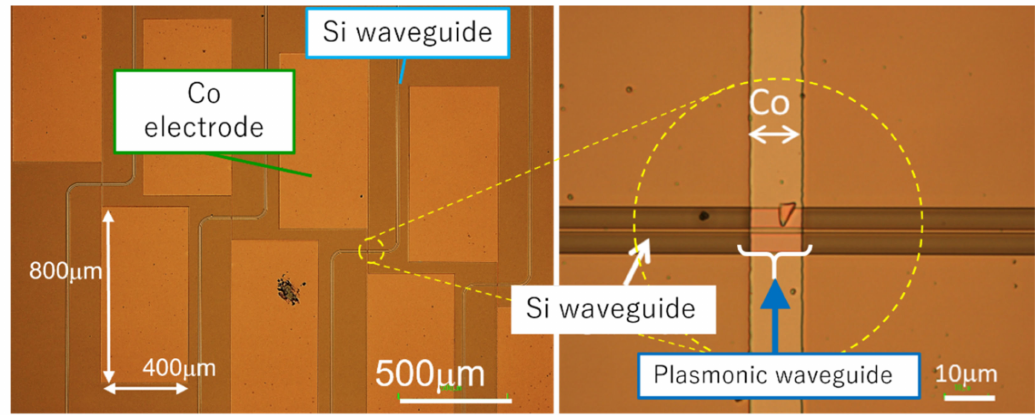
Figure 3. Optical microscope images of the Si plasmonic waveguide heater with electrode